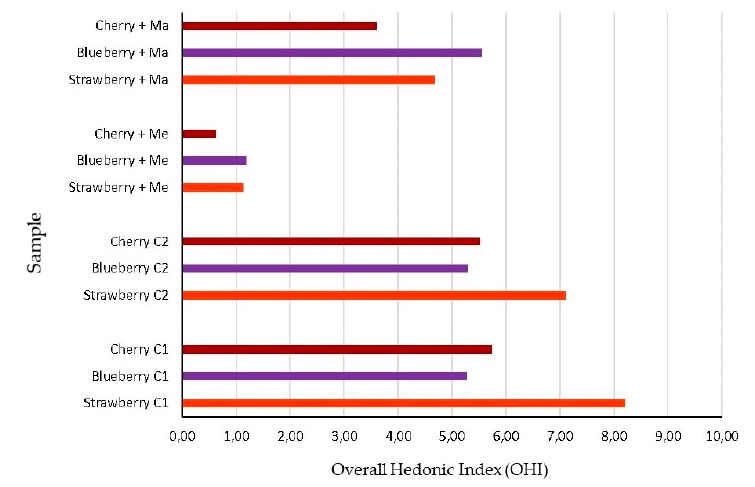
Figure 6. Overall Hedonic Index (OHI) calculated, according to Equation 2, for the essential-oil-dipped fruits (strawberries, blueberries, and cherries) on a scale of 1–10. C1, fruits dipped in distilled water only; C2, fruits dipped in 1% Tween 80 water solution; Me, Melaleuca alternifolia ; Ma, Citrus reticulata .